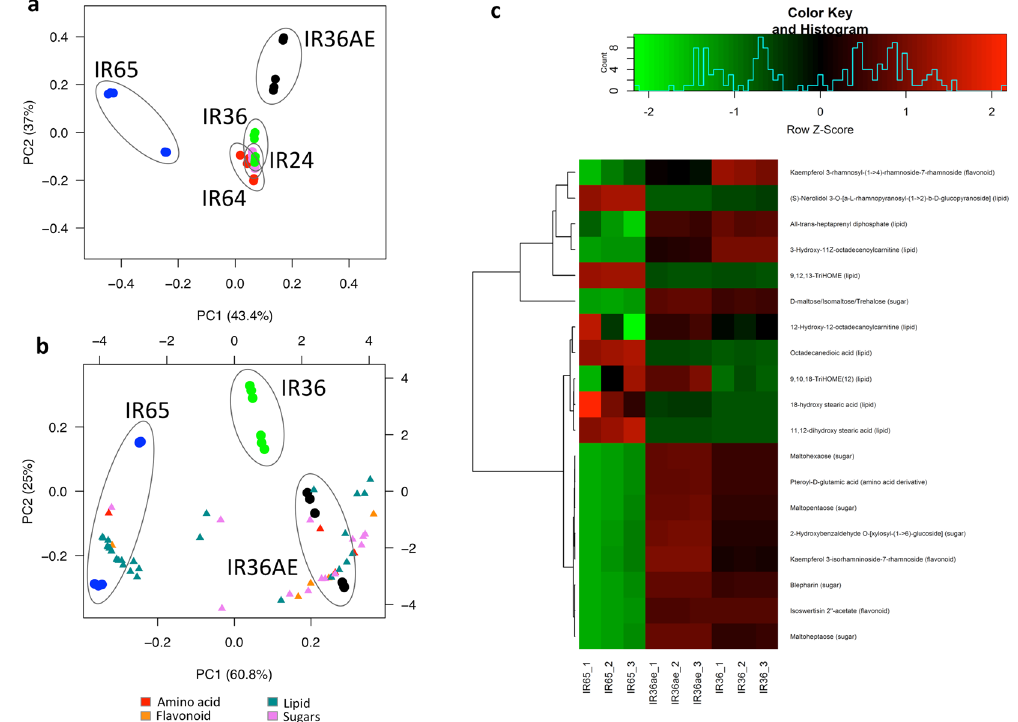
Figure 7. Metabolomics analysis of low, intermediate and high GI lines. PCA plot of ( a ) five contrasting lines with the ( b ) different classes of metabolites that are present in the low, intermediate, and high GI lines. ( c ) Heatmap showing the levels of the metabolites that distinguish the different glycemic index